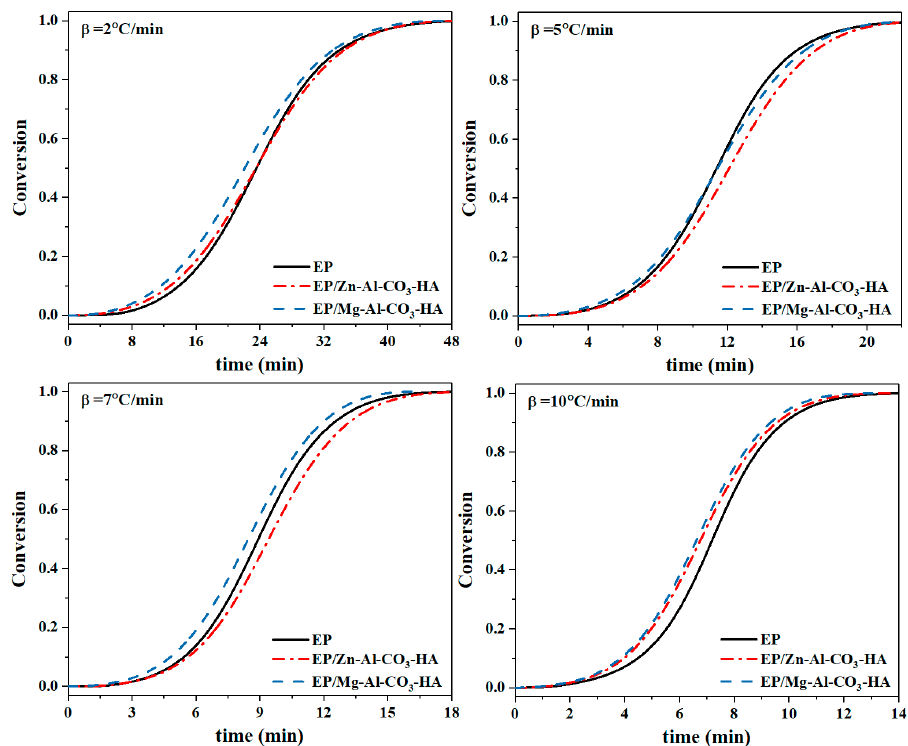
Figure 7. The α -time curves for the EP, EP / Zn-Al-CO 3 -HA, and EP / Mg-Al-CO 3 -HA nanocomposites at heating rates of 2, 5, 7, and 10 °C·min − 1.